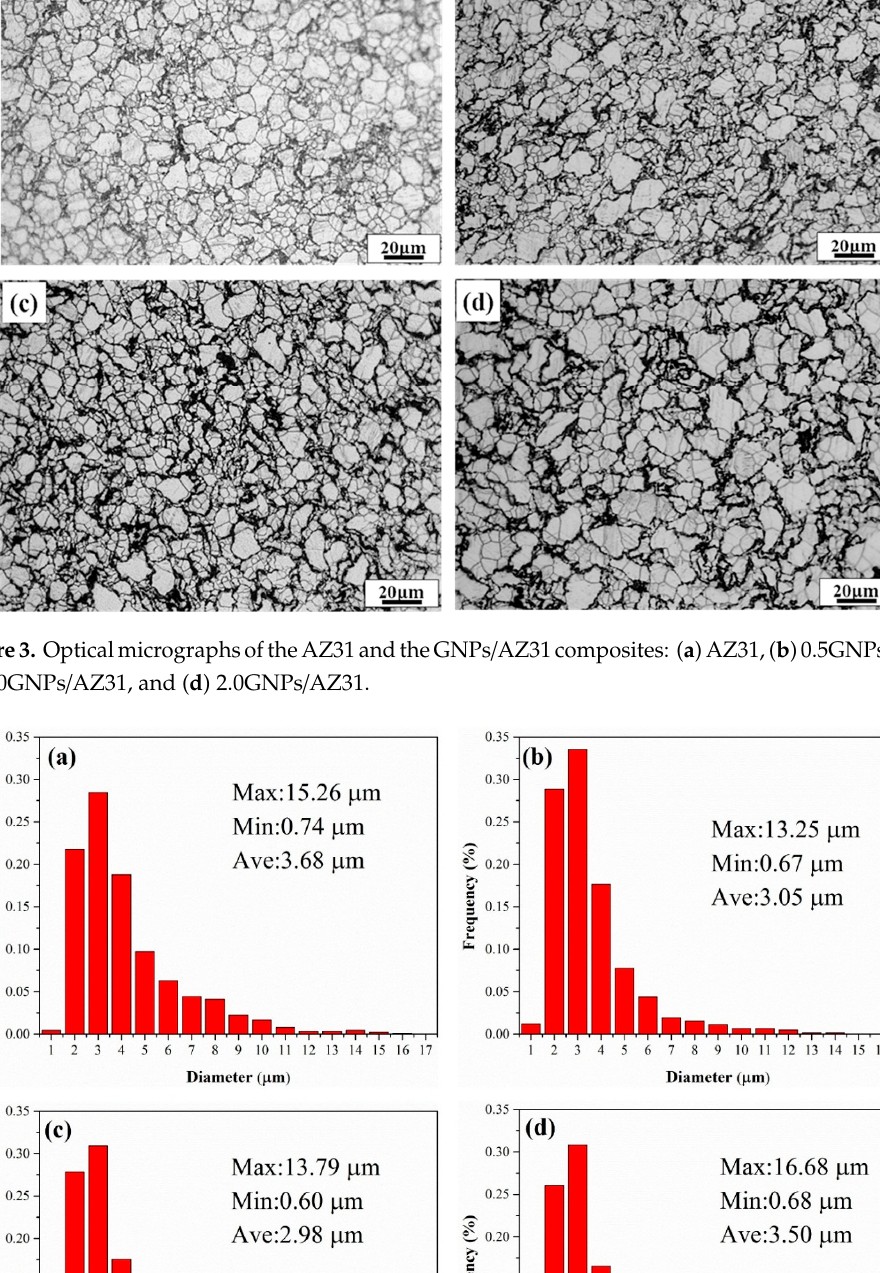
Figure 5. ( a ) SEM images of the 2.0GNPs/AZ31 composites, and ( b – e ) EDS mapping of Mg, Zn, Al and C, respectively.